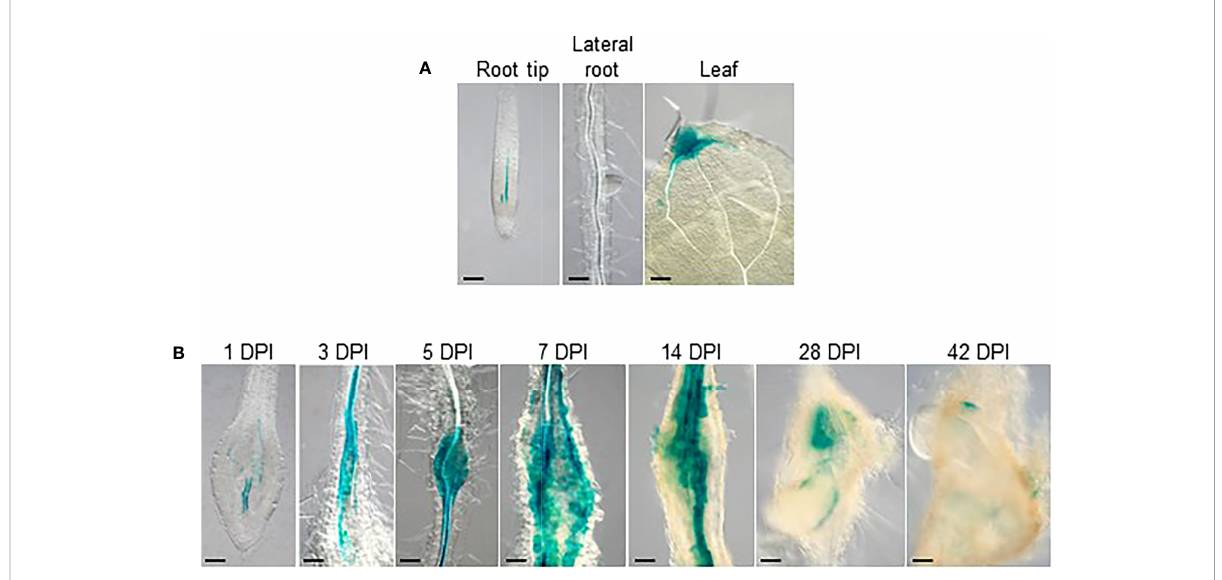
FIGURE 4 YUC4 promoter activity is induced during gall formation. GUS-stained tissues of transgenic Arabidopsis with the pYUC4::GUS reporter construct. (A) Root tip, lateral roots and lea from uninfected plants, (B) 1-42 DPI galls. Bar = 100 μm. At least three independent transgenic lines were examined with similar